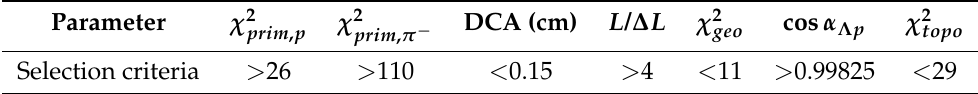
Table 1. Numerical values of the Λ candidate selection